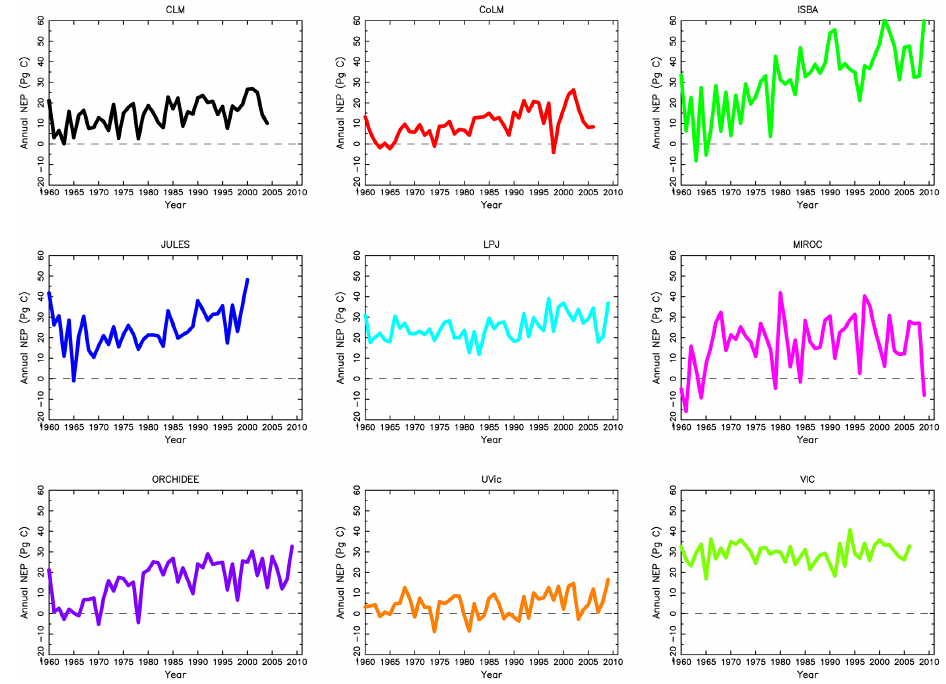
Figure 10. Annual NEP as a spatial average across the region for each year 1960–2009.